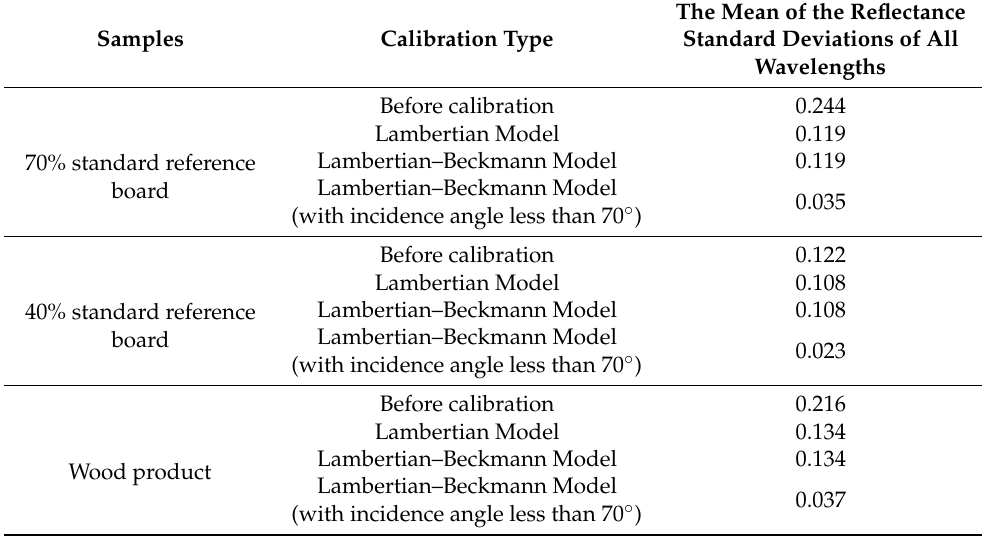
Table 3. The mean of the reflectance standard deviations of all